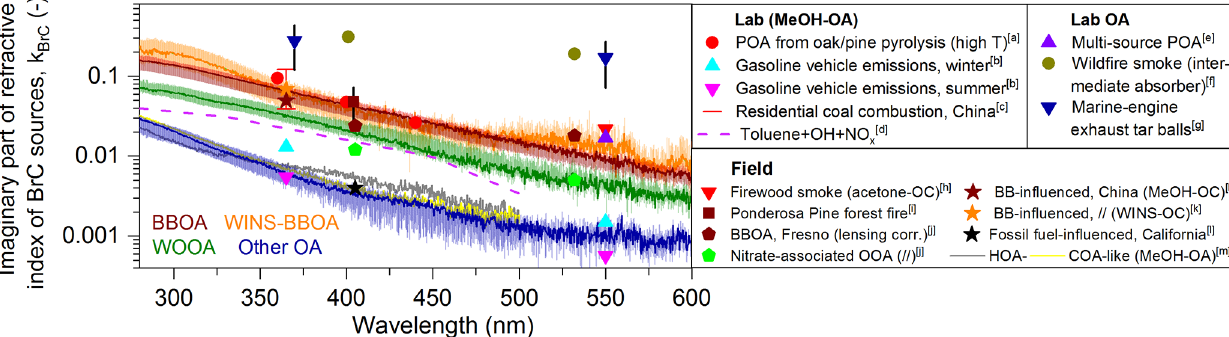
Figure 2. Spectrally resolved median k values (MAE in Fig. S10) of the different methanol-soluble (water-soluble: Moschos et al., 2018) offline AMS–PMF-based OA source components ((WINS-)BBOA corrected for extraction efficiency in MeOH; WINS-BBOA corrected for the water vs. methanol solvent effect; other OA: HOA + COA + SOOA + fOOA), together with the IQR from different UV–vis–PMF sensitivity runs (Sect. S4 and Table S2). The retrieved k BrC values are compared to those of previous laboratory and field studies focusing on methanol-extractable or total organics: (a) Chen and Bond (2010), (b) Xie et al. (2017), (c) Li et al. (2019), (d) Liu et al. (2015), (e) Lu et al. (2015), (f) Adler et al. (2019), (g) Corbin et al. (2019), (h) Kirchstetter et al. (2004), (i) Lack et al. (2012), (j) Cappa et al. (2019), (k) Yan et al. (2020), (l) Cappa et al. (2012), (m) Moschos et al.